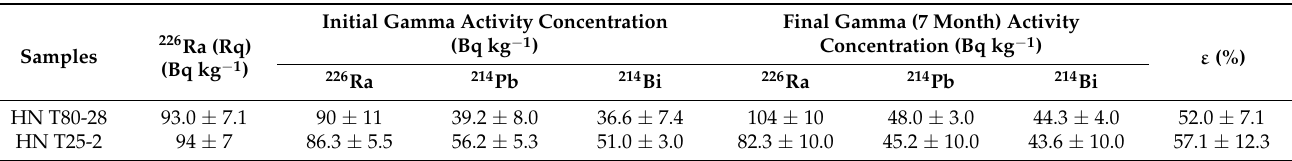
Table 10. 226 Ra, 214 Pb and 214 Bi activity concentrations initially determined with gamma spectrometry and 7 months later with radiochemical separation and solid-state ZnS(Ag) scintillation detector measurements.